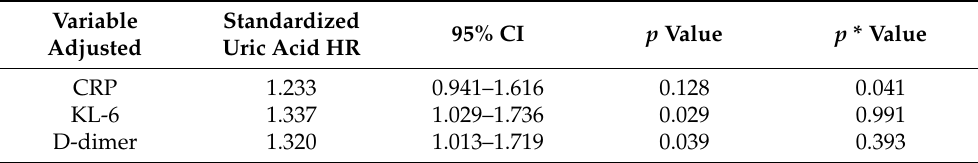
Table 4. Association of serum uric acid level at time of admission with progression from non- severe to severe coronavirus disease 2019 (COVID-19), with additional adjustments for markers of inflammation, alveolar damage, and coagulation